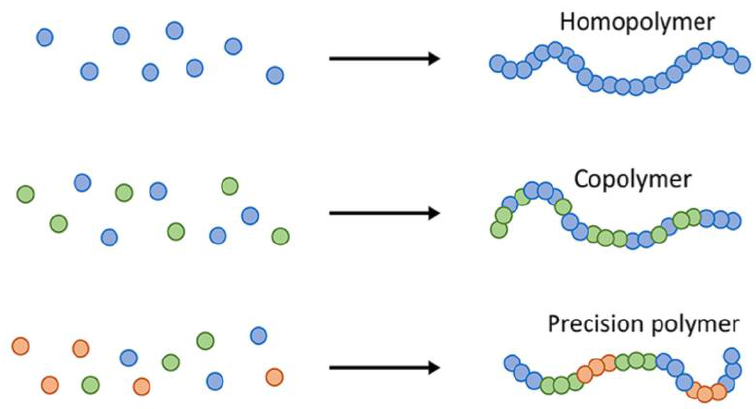
Figure 1. Differences between homopolymers, copolymers, and precision polymers.